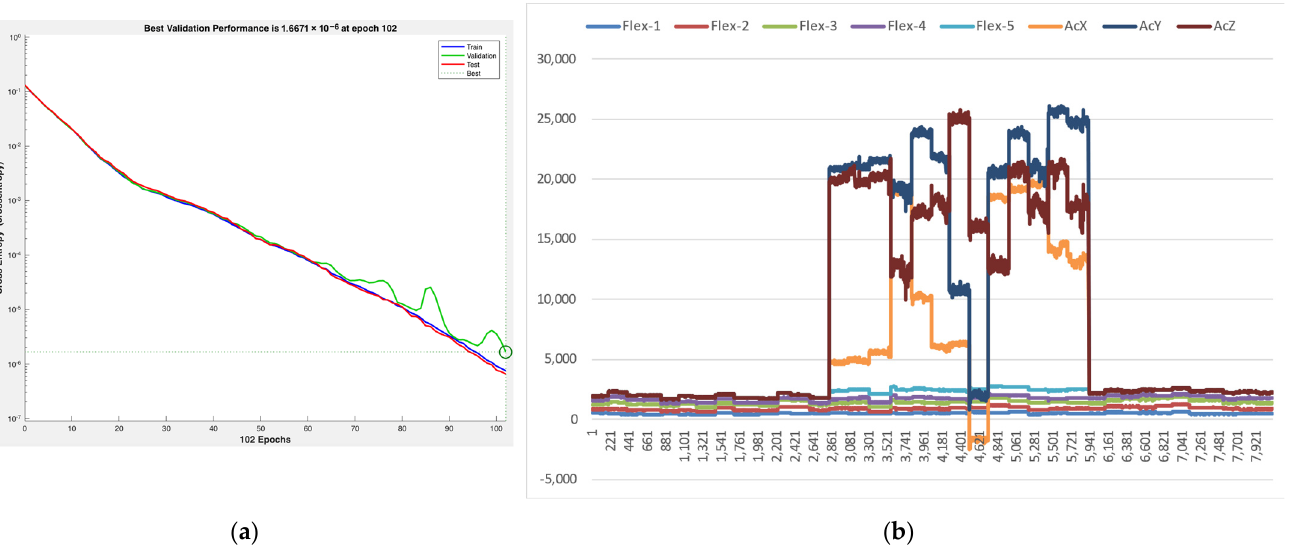
Figure 6. Training, validation, and testing performance plot ( a ) along with flex sensors values plot ( b ) for the alphanumeric dataset.